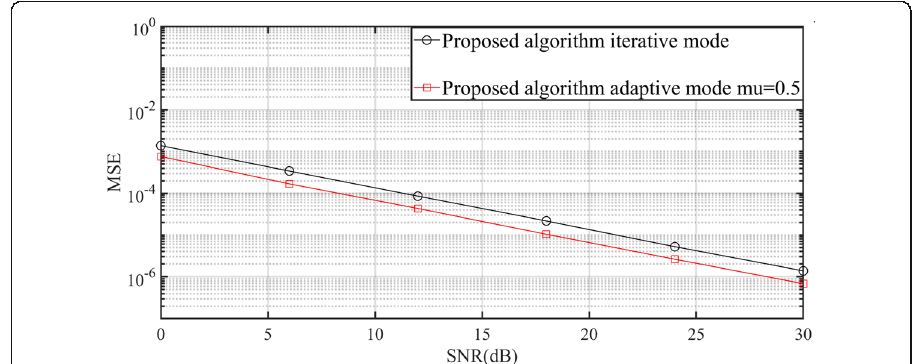
Fig. 9 The MSE performance for CFO estimation in the adaptive mode at v = 0 km/h